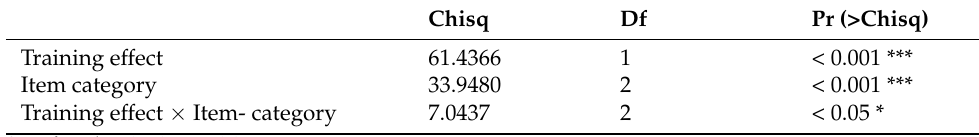
Table 9. Summary of the effects in the experiment (natural